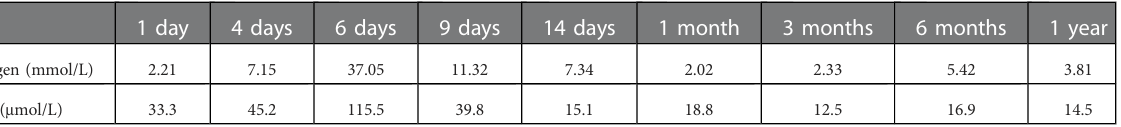
TABLE 1 Changes in renal function – related indexes after birth.